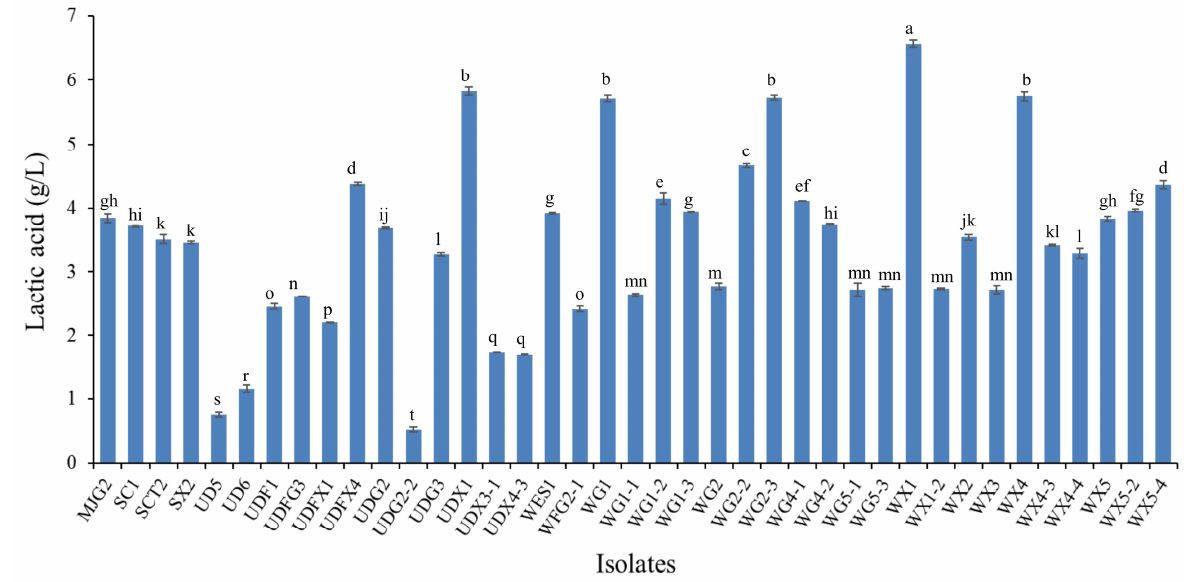
Figure 1. Lactic acid production from 39 isolates in MRS with 10 g/L xylose after cultivation at 37 °C for 48 h. Different small letters indicate significant differences between lactic acid produced from each isolate ( p < 0.05).